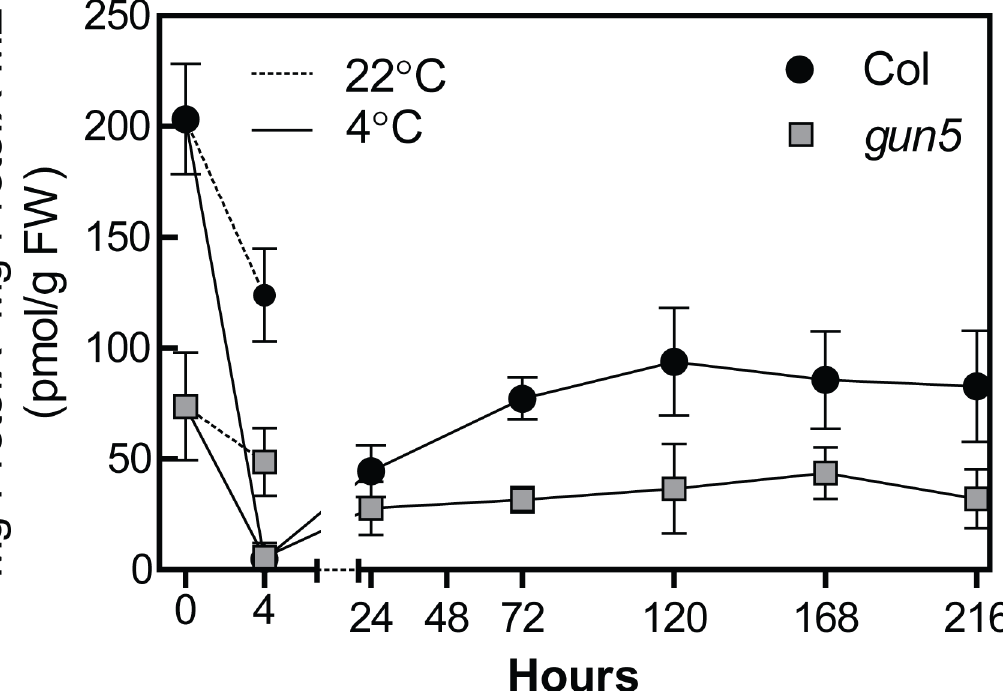
Fig 4. Levels of Mg-ProtoIX and Mg-ProtoIX-ME in Col-0 and gun5 following exposure to low temperatures. Plants were grown for 5 weeks in SD conditions and transferred to cold conditions and sampled after indicated time points where time point 0 is the middle of the day. The first sample (4h) was taken at the end of the light period of the first day. Each data point represents at least 3 biological replicates ( ± SD).